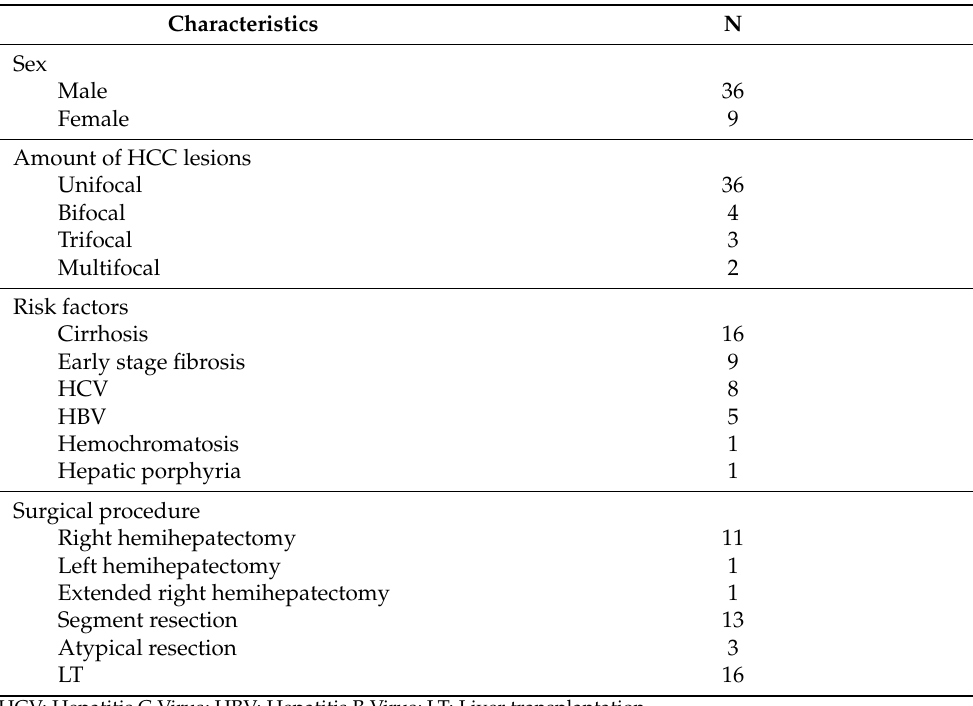
Table 1. Characteristics of the study group ( n = 45). Mean age ± SD was 63 ± 14 years (range